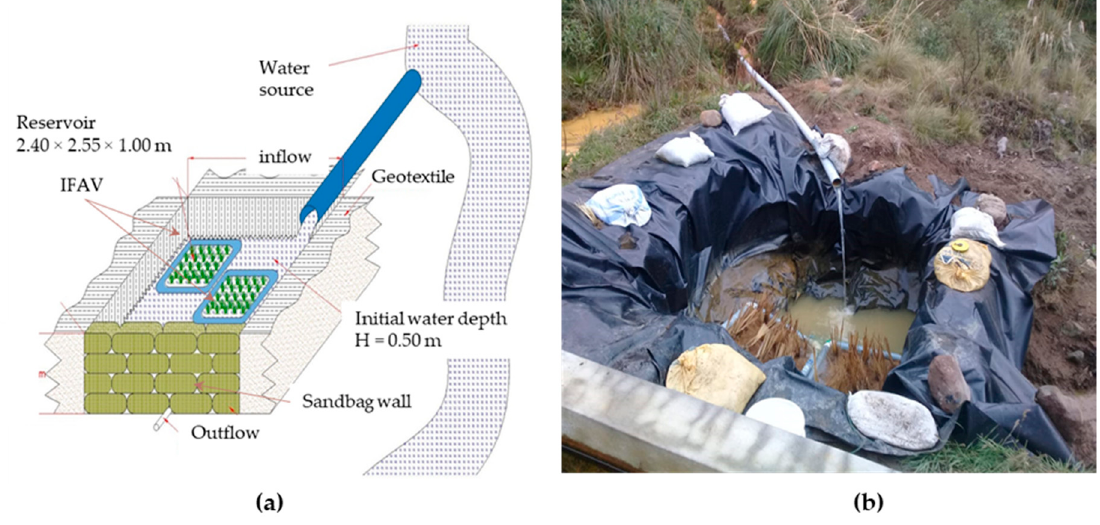
Figure 2. Irrigation reservoir configuration with AFIV: ( a ) system site configuration and ( b ) actual reservoir with AFIV.